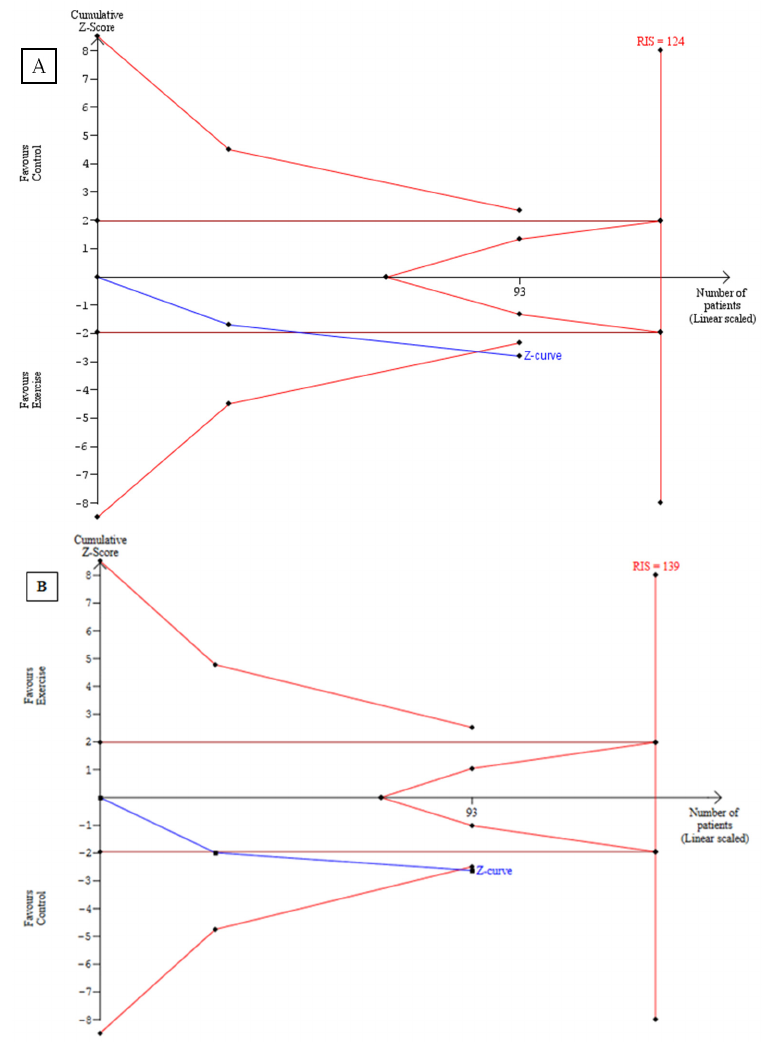
Figure 3. Trial sequential analysis—effect on ( A ) SD1 and ( B )